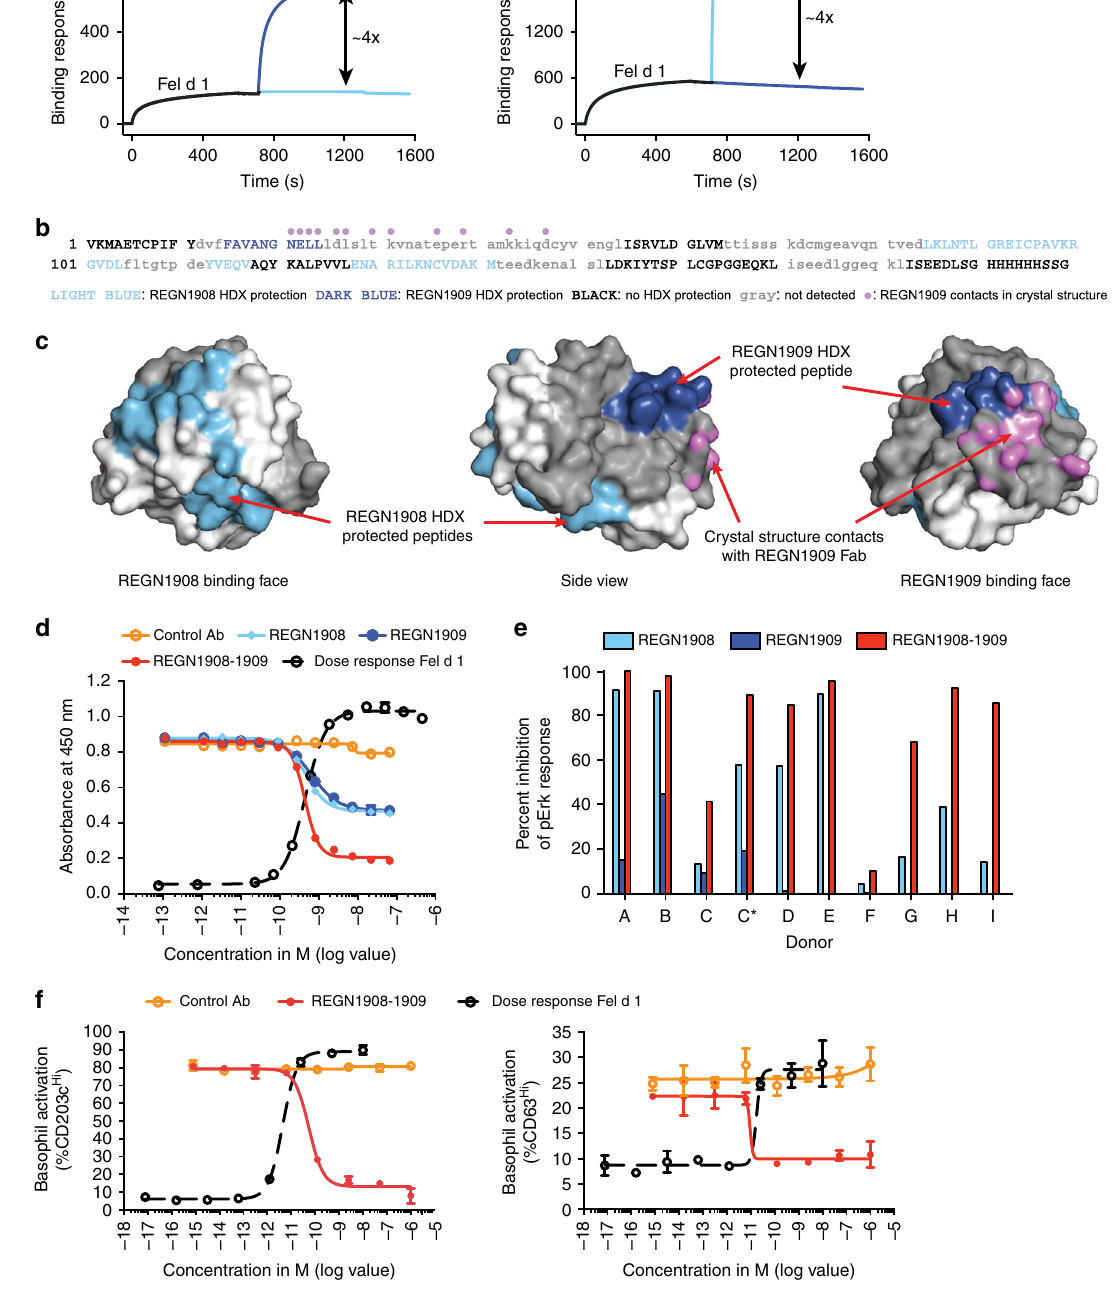
d 1 stimulation with varying intensities (Supplementary Fig. 2). REGN1908 – 1909 inhibited at least 80% of basophil activation in 7/10 donors, while a single antibody (REGN1908) achieved the same magnitude of inhibition in only 3/7 donors (Fig. 2e, Supplementary Fig. 2). In the basophil activation test (BAT), which measures allergen-induced upregulation of the basophil activation markers, CD203c and CD63, by fl ow cytometry 21 , REGN1908 – 1909 potently blocked Fel d 1-induced basophil activation (IC 50 values of 55pM and 10 pM, respectively) (Fig. 2f).